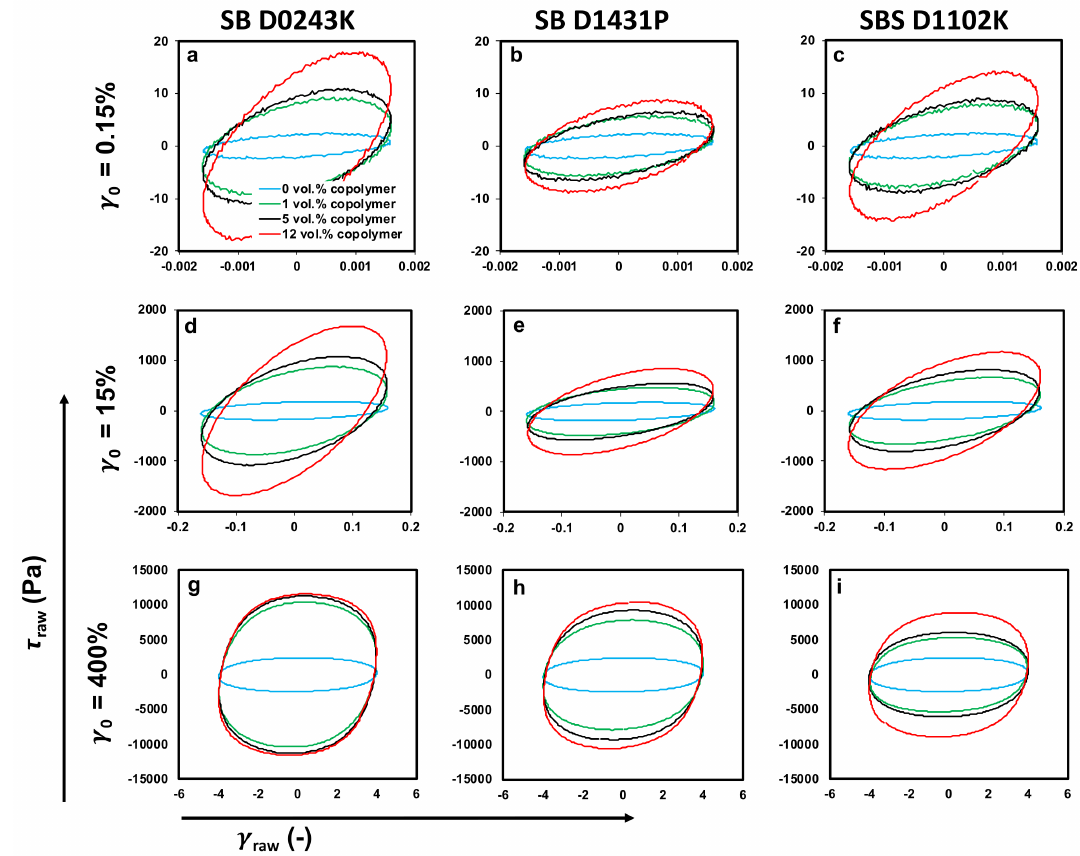
Figure 12. ( a – i ) Elastic Lissajous–Bowditch loops for PP:PS/70:30/MWCNT 1 vol.% and PP:PS/70:30/MWCNT 1 vol.%/copolymers. Projections on the elastic ( τ − γ ) plane are presented at strain amplitudes of γ 0 = 0.15%, 15%, and 400% and an angular frequency of ω = 1 rad/s at 200 ◦